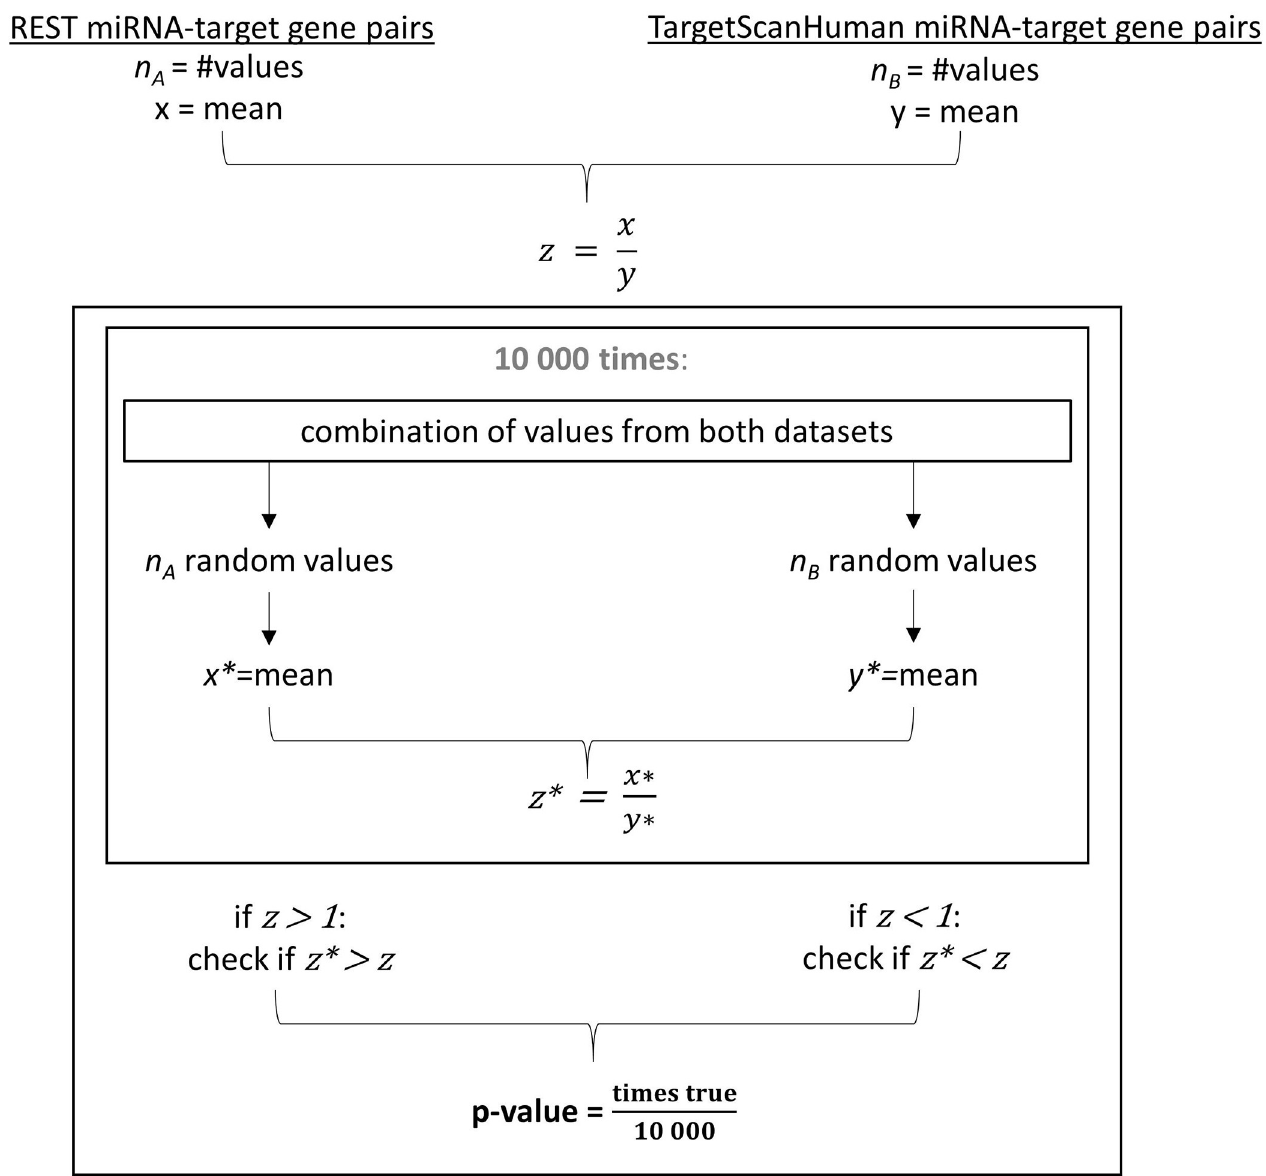
Fig 3. Illustration of p-value calculation by conducting 10,000 random tests for the statistical comparison of two sample means.